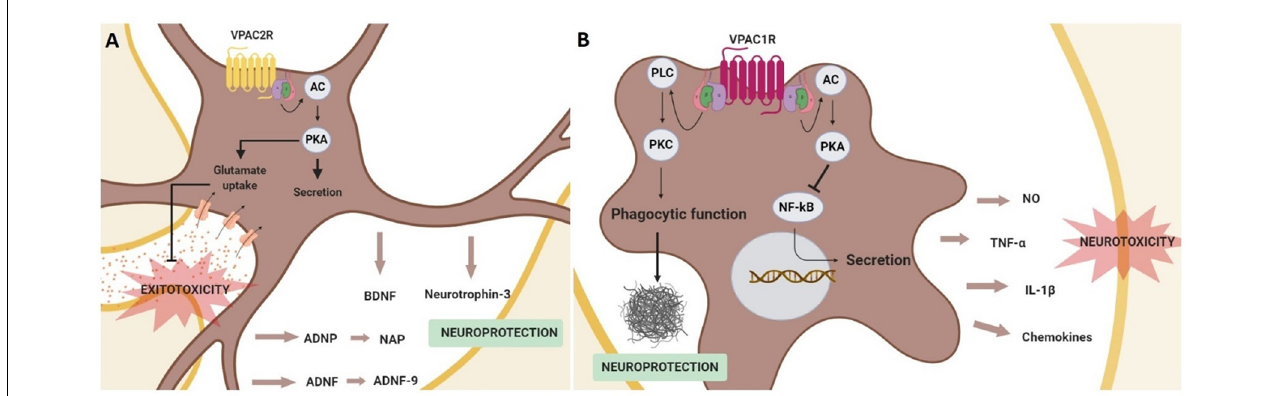
FIGURE 4 | Schematic representation of neuroprotective effects mediated by the activation of the VPAC receptors in glial cells. In astrocytes (A) VPAC2R activation promotes the secretion of neurotrophic and neuroprotective factors, in addition to prevent neurons from excitotoxicity by enhancing the glutamate re-uptake in astrocytes. These actions are associated with adenylyl cyclase (AC)/protein kinase A (PKA) activation. In microglia (B) the stimulation of VPAC1R inhibits the secretion of pro-inflammatory agents through the activation of the PKA signaling pathway and protects against β -amyloid fibrils enhancing the microglia phagocytic function via protein kinase C (PKC)